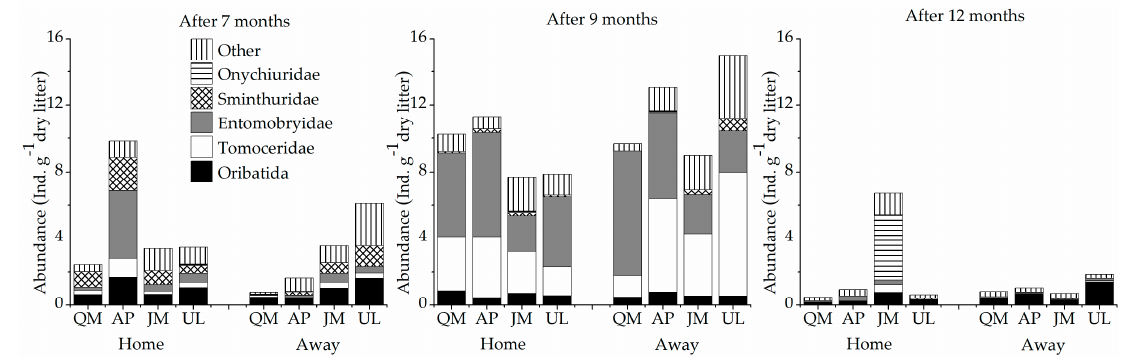
ff erent litter types during the experimental period.